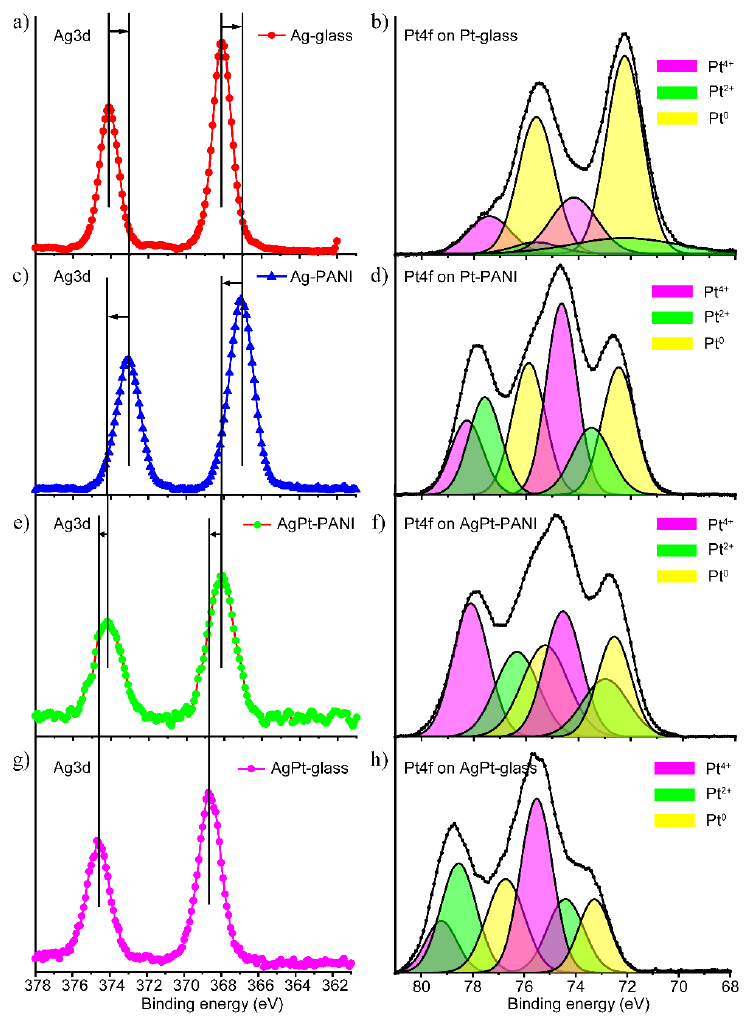
Figure 4. Left: XPS data for silver; right: XPS data for Pt. ( a , b ) Monometallic NPs on glass; ( c , d ) monometallic NPs on PANI; ( e , f ) bimetallic NPs on PANI; ( g , h ) bimetallic NPs on glass.